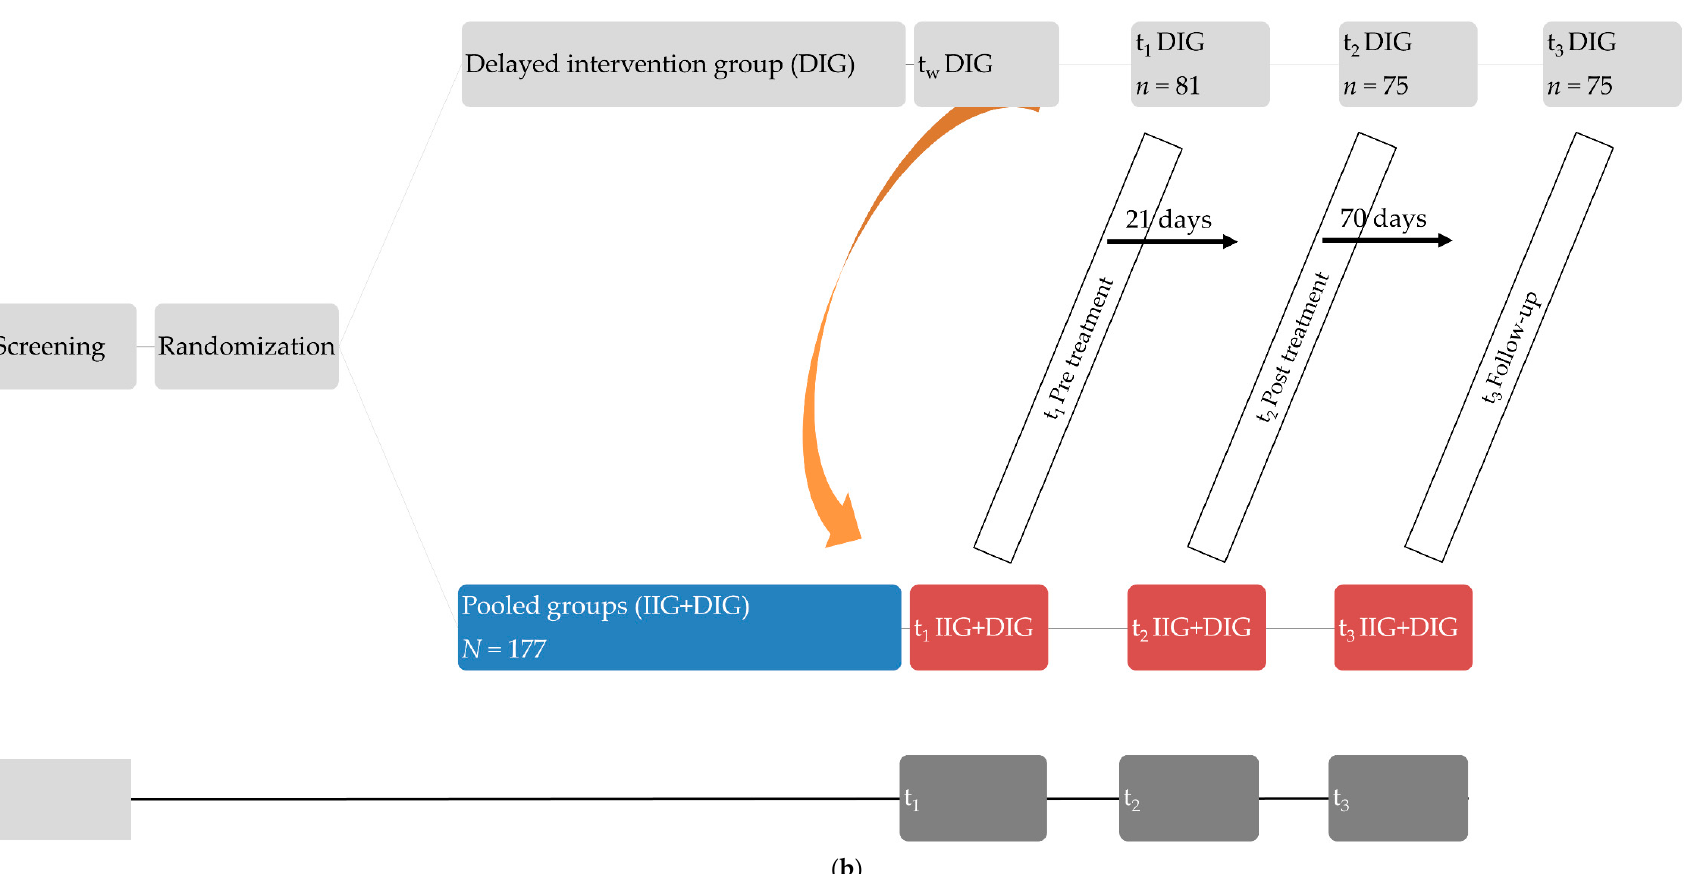
Figure 1. ( a ) Overview of the randomised, controlled cross-over design, measurement timepoints, and dropouts. IIG = immediate intervention group; DIG = delayed intervention group; t 1 = pre-treatment; t 2 = post-treatment; t 3 = follow-up; t w = waiting timepoint (DIG only). Dropout rates are indicated for each arm and measurement timepoint; ( b ) within-subject analyses investigating treatment-related effects in the pooled sample as applied in the present study. Pooling for ( b ) was possible because the IIG and DIG did not differ on any of the investigated outcome measures at screening (t 0 ) or pre-treatment (t 1 IIG; t 1 DIG).